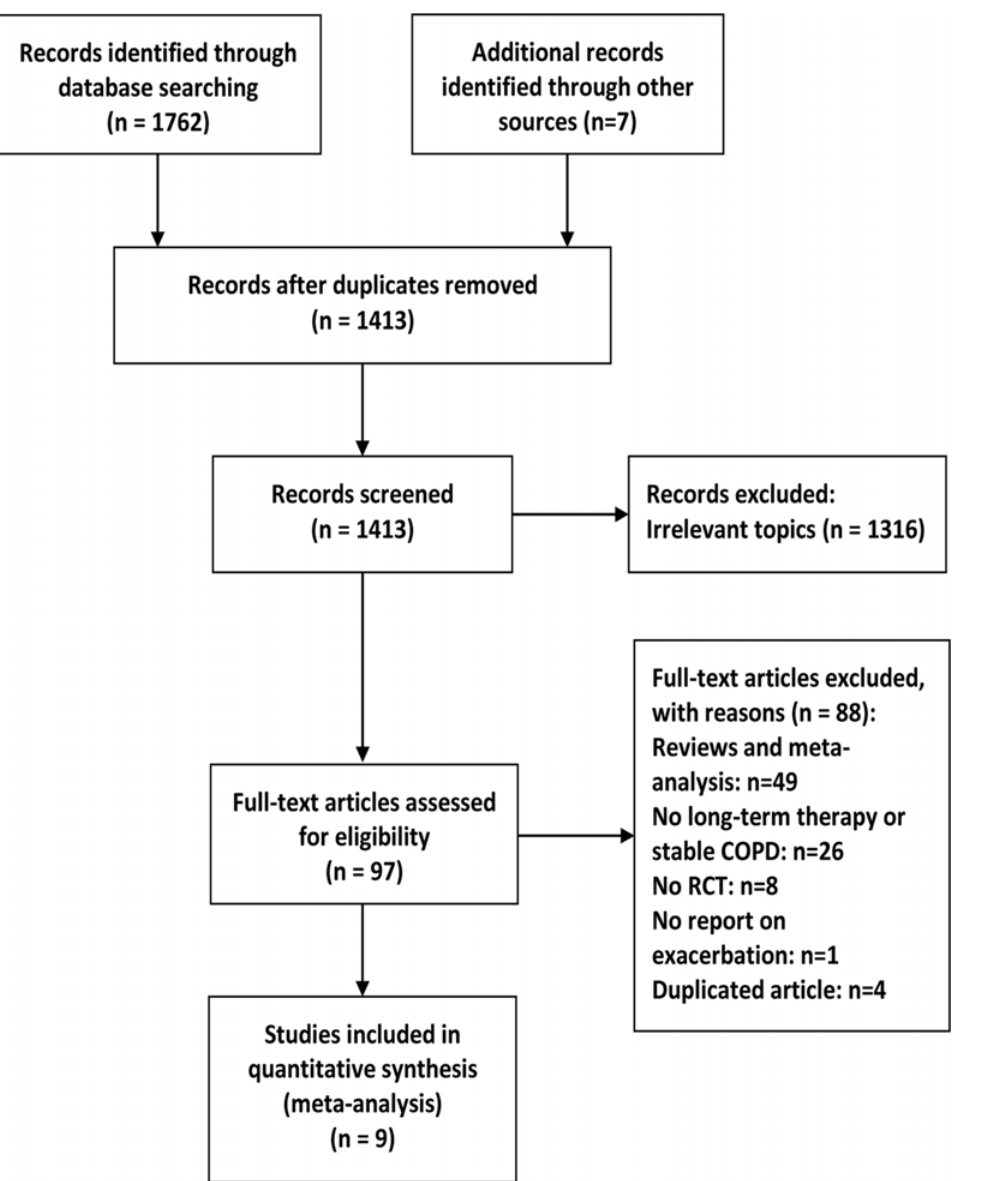
Fig 1. Flow diagram of included